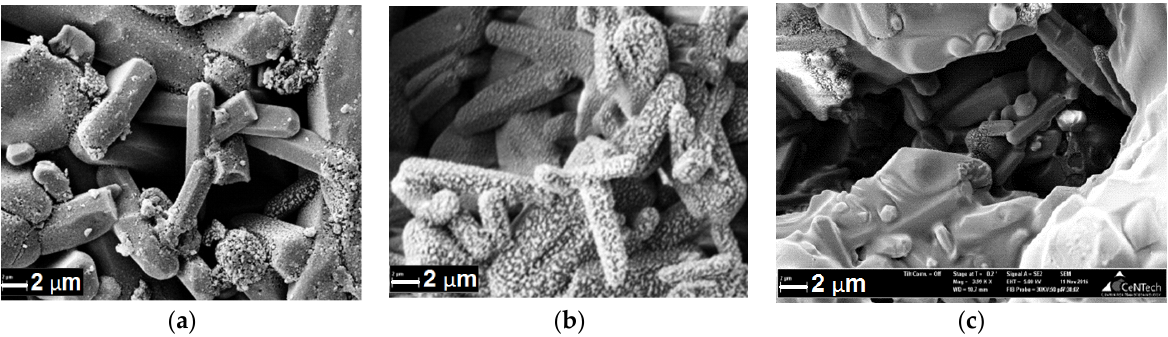
Figure 10. SEM images of the surface of composites ( a ) HA (90)-PLGA, ( b ) HA (75)-PLGA, ( c ) HA (50)-PLGA.